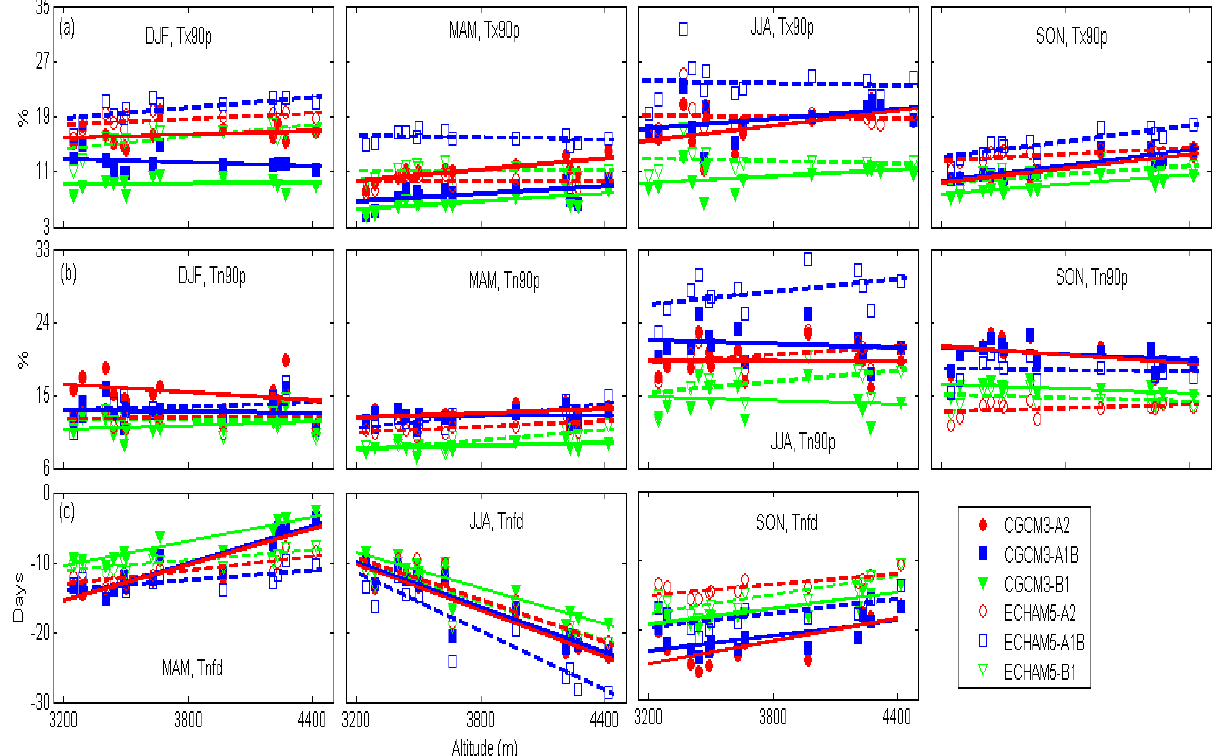
Fig. 5. As in Fig. 4, but for the frequency-related indices. mean minimum temperature and cold night (Tnav,